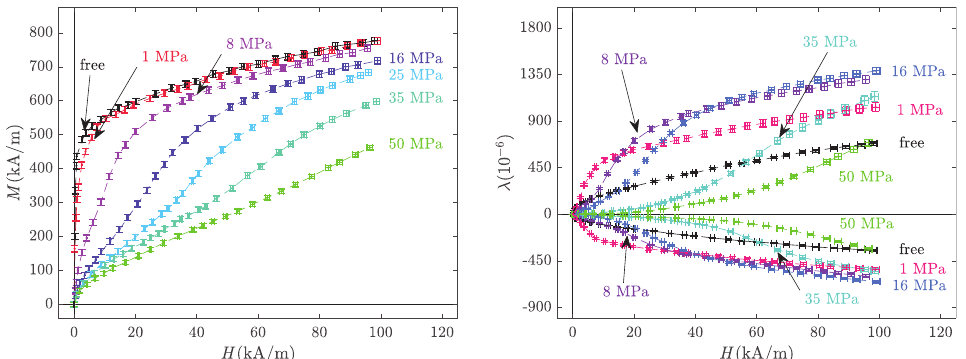
Figure 3. Anhysteretic magneto-elastic behaviour: magnetisation ( left ) and magnetostriction strain ( right ) at various levels of compressive stress with the corresponding error bars. Experimental